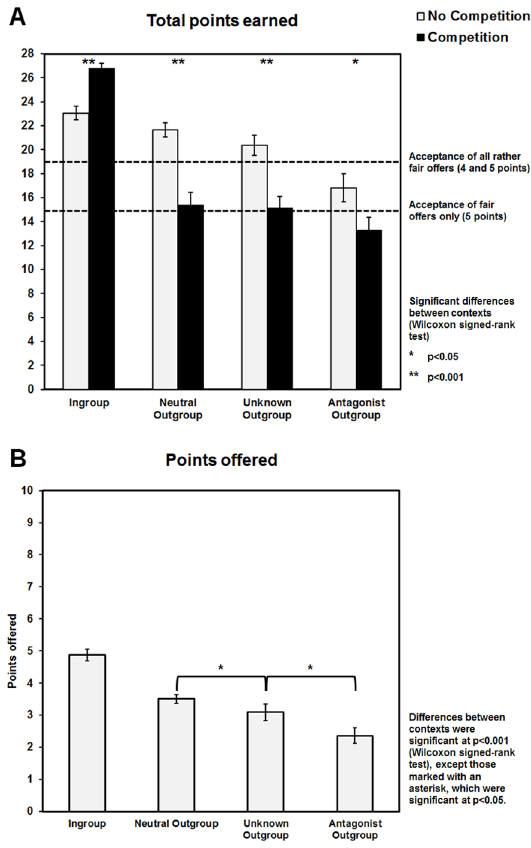
Figure 3. The individual outcome (total points earned) and proposer generosity depended on group membership and context. (A) Subjects earned significantly more points in ingroup interactions and significantly less points in outgroup interactions in the competitive context relative to the neutral context. (B) The number of points offered differed between groups.